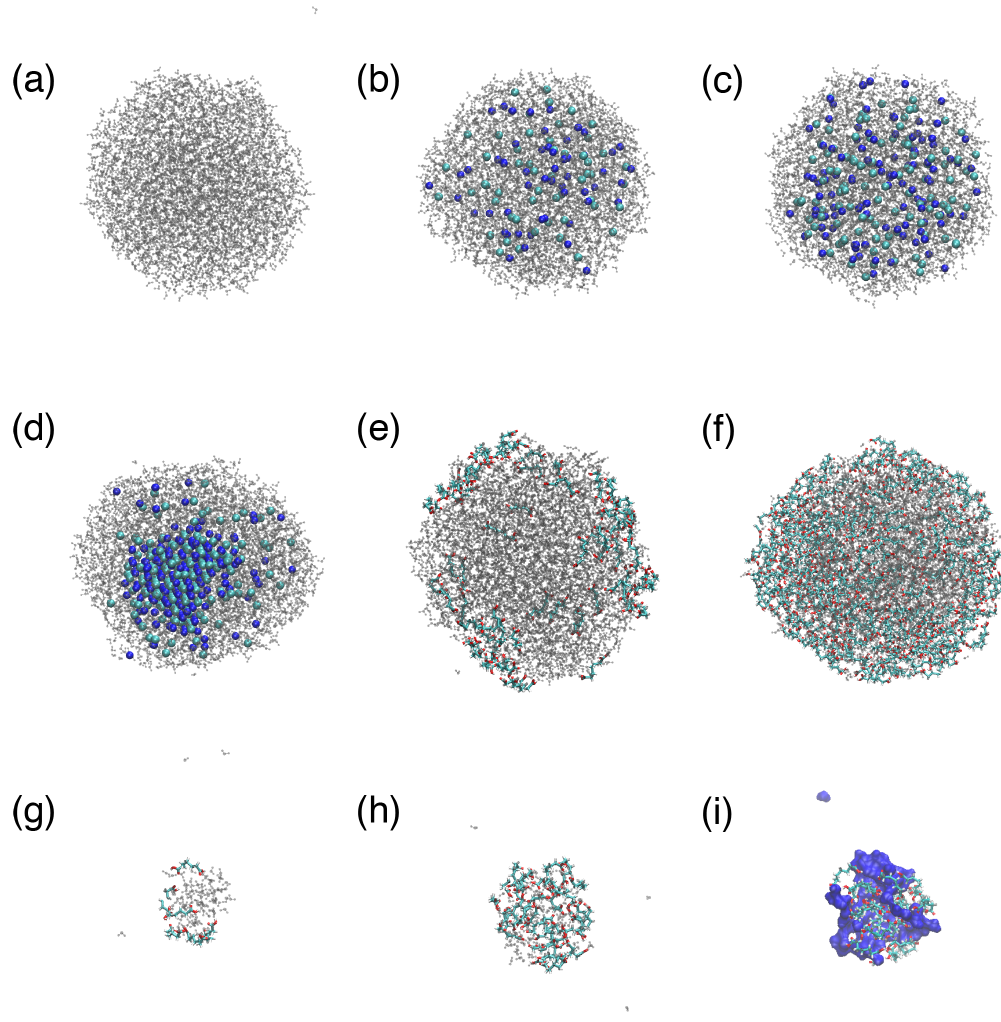
Figure A3. MD simulation snapshots of droplets with water (gray color), Na + (dark-blue spheres), Cl − (light-blue spheres), and pimelic acid (colored chains with O atoms in red, C atoms in light blue, and H atoms in white): (a) N w = 3000; (b–d) 1, 2, and 4m NaCl solutions with N w = 3000; (e, f) low and high organic loadings with N w = 3000; and (g, h) low and high organic loadings with N w = 100. Panel (i) shows the same system as panel (h) (high-organic-loading cluster with N w = 100) but with water represented as a dark-blue surface.